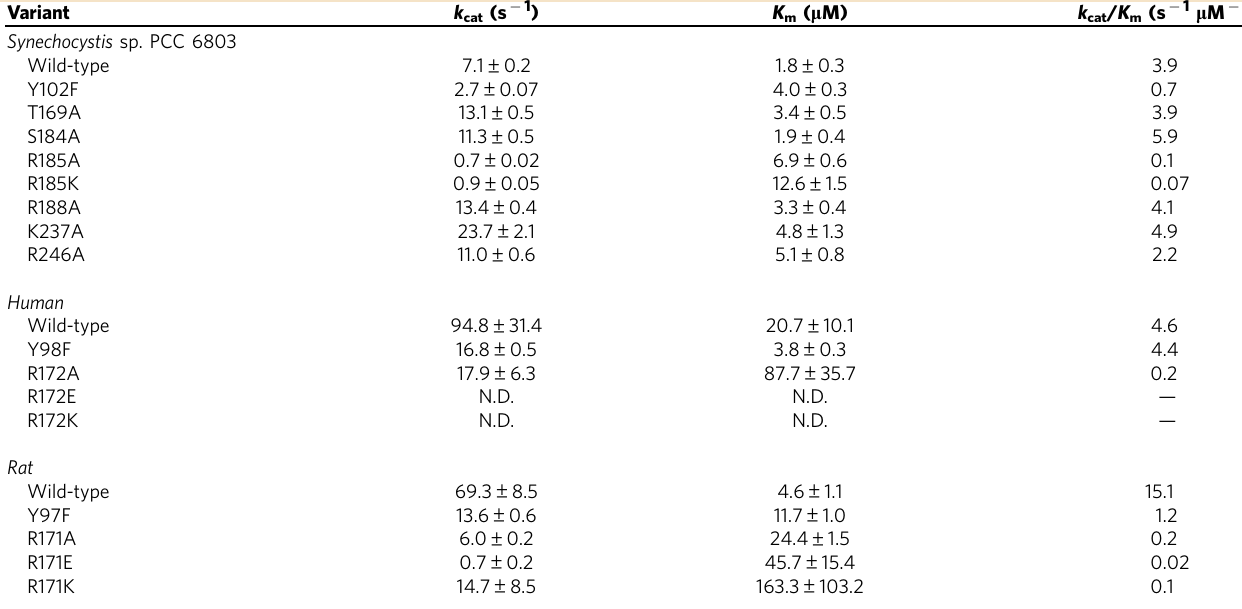
Table 2 | Kinetic parameters of wild-type and mutant proteins of Syn , human and rat BVRs* , w .